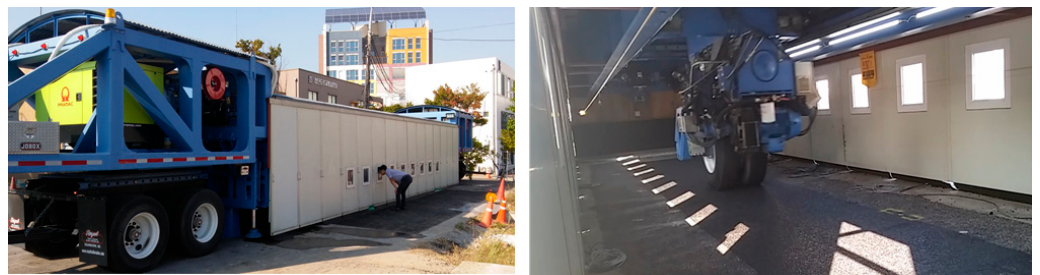
Figure 6. Accelerated pavement testing (APT) facility.